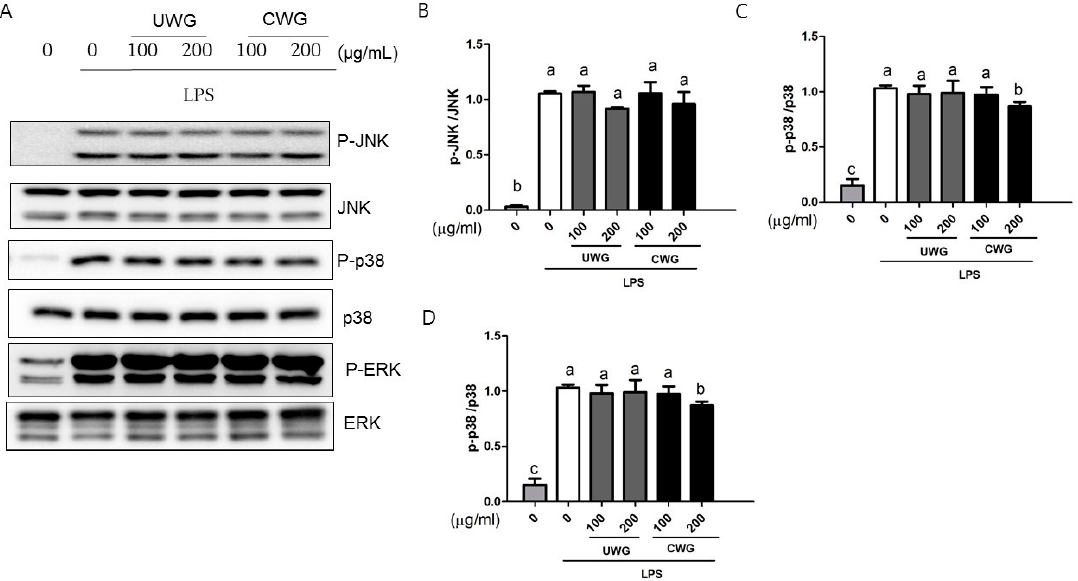
Figure 6. Effect of CWG on LPS-induced MAPK (JNK, ERK, and p38) activation. Mouse peritoneal macrophages were pretreated with UWG or CWG for 1 h and then stimulated with LPS for 15 min. ( A ) The expression level of phosphorylated MAPKs was determined by Western blotting. One of three experiments is shown; ( B – D ) Each phosphorylated protein was normalized with its total protein ( n = 3). Different letters indicate statistical significances ( p < 0.05).